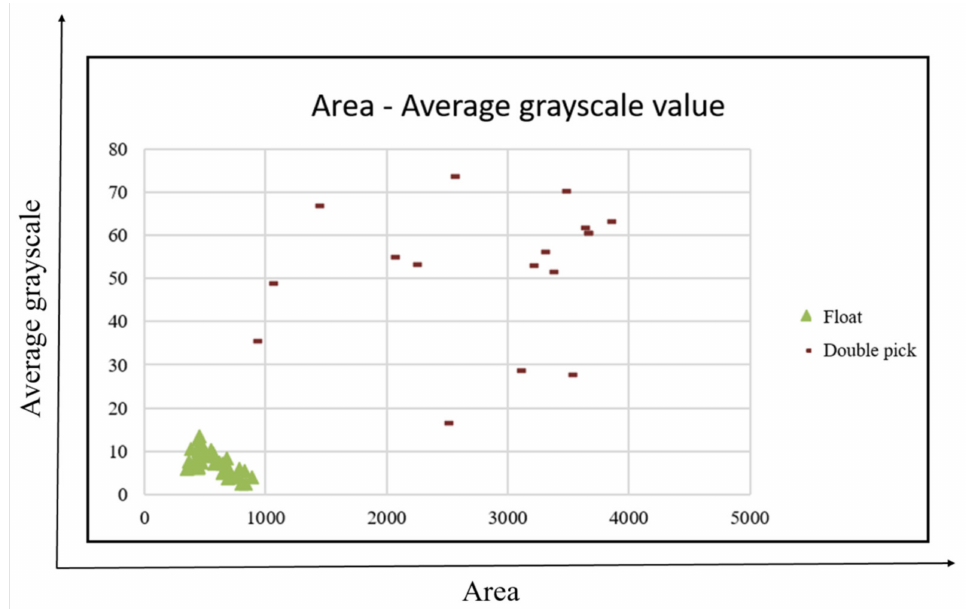
Figure 14. Area vs. average grayscale value feature distribution.